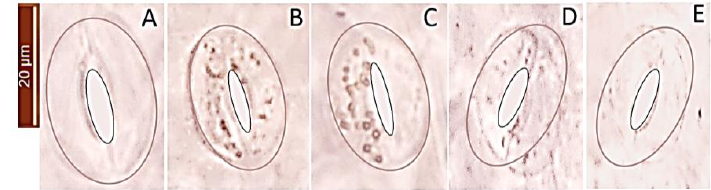
Figure 11. DAB (3,3’-Diaminobenzidine) staining for detection of H 2 O 2 in guard cell under control ( A ) and 300 mM NaCl ( B–E ). ( B ) control (zero ascorbic acid, AsA); ( C ) 150 mg L − 1 AsA; ( D ) 300 mg L − 1 AsA; E : 450 mg L − 1 AsA. Formation of brown precipitates showed the generation of H 2 O 2 by guard cells. The borders of guard cells and stomatal pores were lined to make it more contrasting with the background. Raw images (without GC outlines) are provided in the Supplemental Figure S4. One (of 15) typical images is shown.